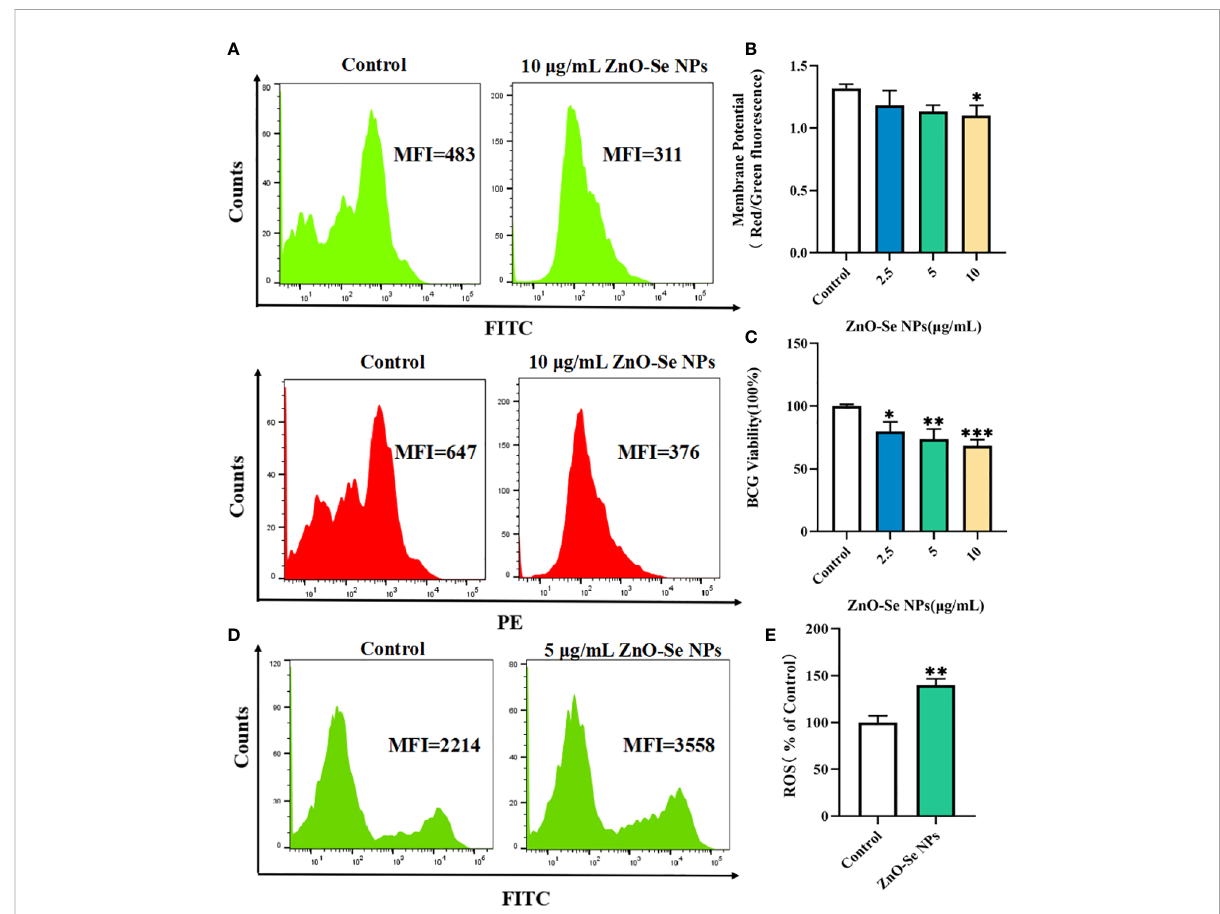
FIGURE 3 Killing/inhibition mechanisms of ZnO-Se NPs against Mtb. (A) Typical fl ow cytometry analysis of membrane green and red signals for BCG before and after 10 m g/mL ZnO-Se NPs treatment. (B) Statistical results of membrane potential for BCG before and after ZnO-Se NPs treatment, n=3, *p<0.05. (C) Viability analysis by detecting the ATP production of BCG before and after ZnO-Se NPs treatment, n=3, *p<0.05, **p<0.01, ***p<0.001. (D) Typical fl ow cytometry analysis of ROS levels for BCG before and after 5 m g/mL ZnO-Se NPs treatment. (E) Statistical results of ROS level for BCG before and after ZnO-Se NPs treatment, n=3,